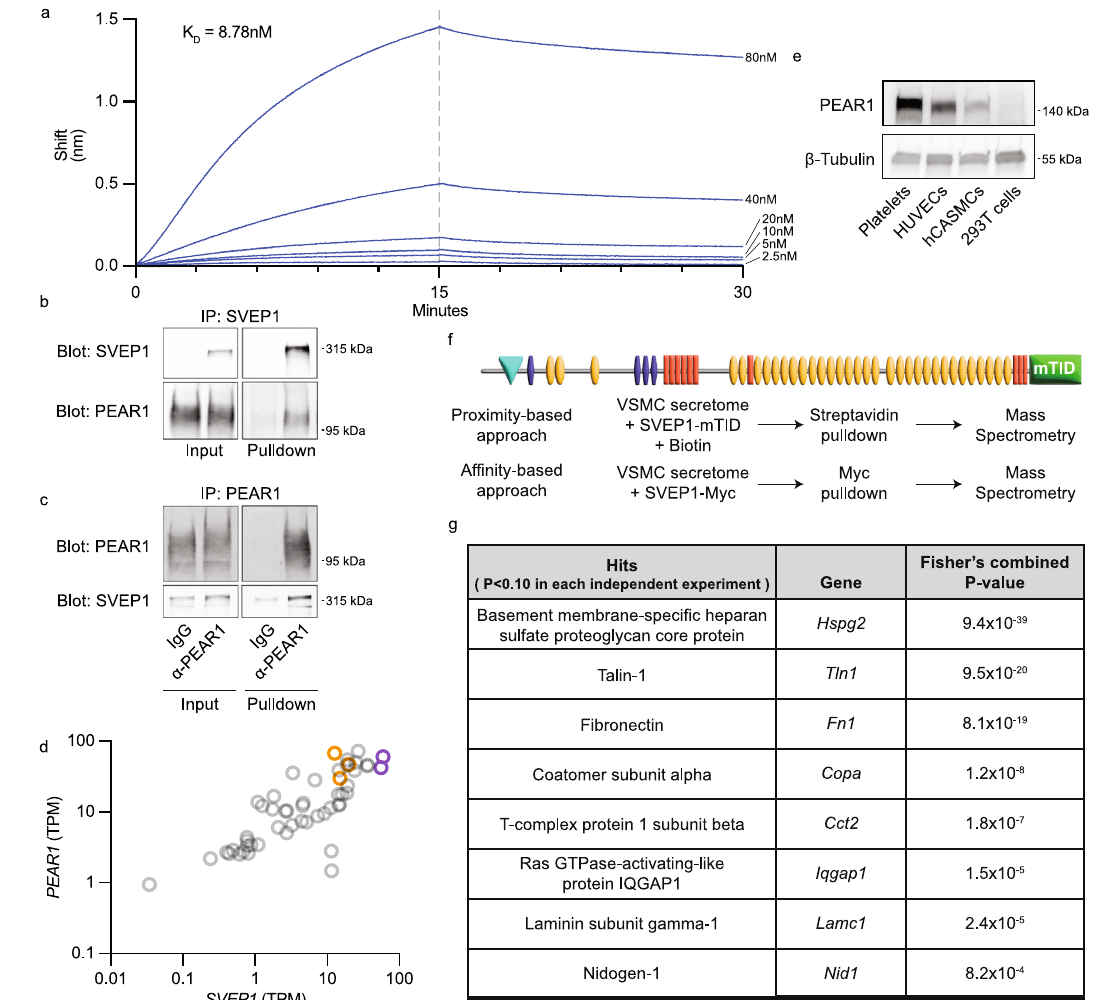
Pearson r correlation=0.74, P =3.5×10 − 10 . e Immunoblot analysis of PEAR1